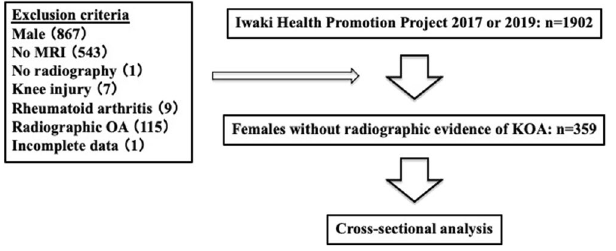
Figure 1. Flow of participants enrollment in Iwaki Health promotion project. Finally, 359 females were enrolled for the statistical